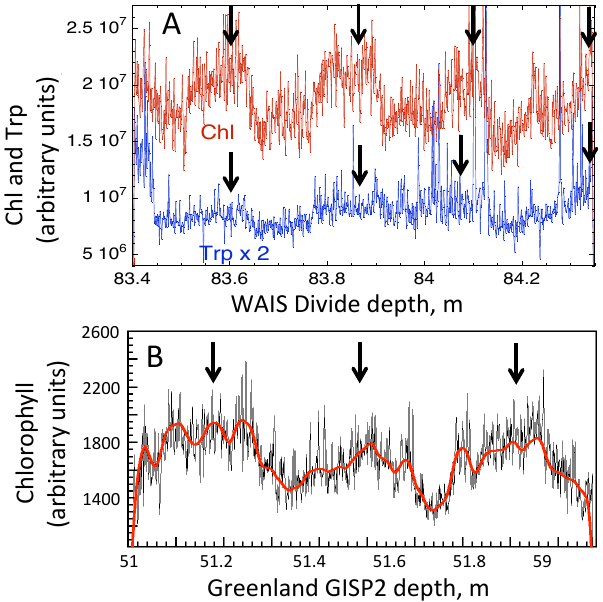
Fig. 1. Chl autofluorescence (arbitrary units) at several depths in ice cores showing fluctuations consistent with summer-winter vari- ations. (A) Chl and Trp over 4yr in WAIS Divide ice; summer max- ima are marked with arrows; (B) Chl in Greenland ice shows max- ima during 3 summers; wiggly red line is a spline fit to the